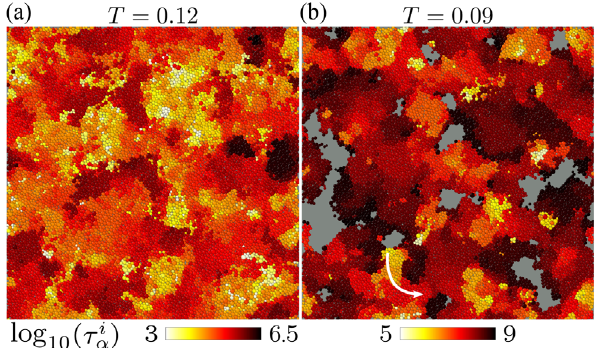
FIG. 14. Maps of local relaxation time reveal the emergence of dynamic facilitation. Map of a local relaxation time τ i α in the two- ≤ 0 . 5 and dimensional system definedas the first time at which C i B (a) T ¼ 0 . 12 ¼ T and (b) T ¼ 0 . 09 . The color codes for the MCT valueof τ i α areonalogarithmicscale.In(b),thearrowhighlightsthe emergence of dynamic facilitation, and gray regions have not yet 8 × 10 8 . The box size is L ¼ 100 relaxed at t max ¼